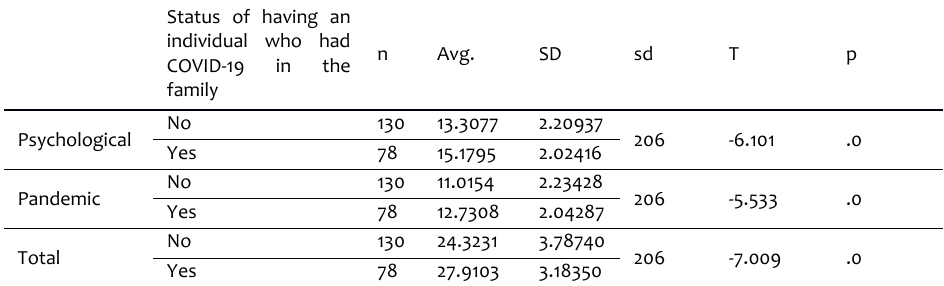
Table 6. The mean scores and t-test results of the reactions of the children to the pandemic according to the presence of individuals who have had COVID-19 in the family (n=208)